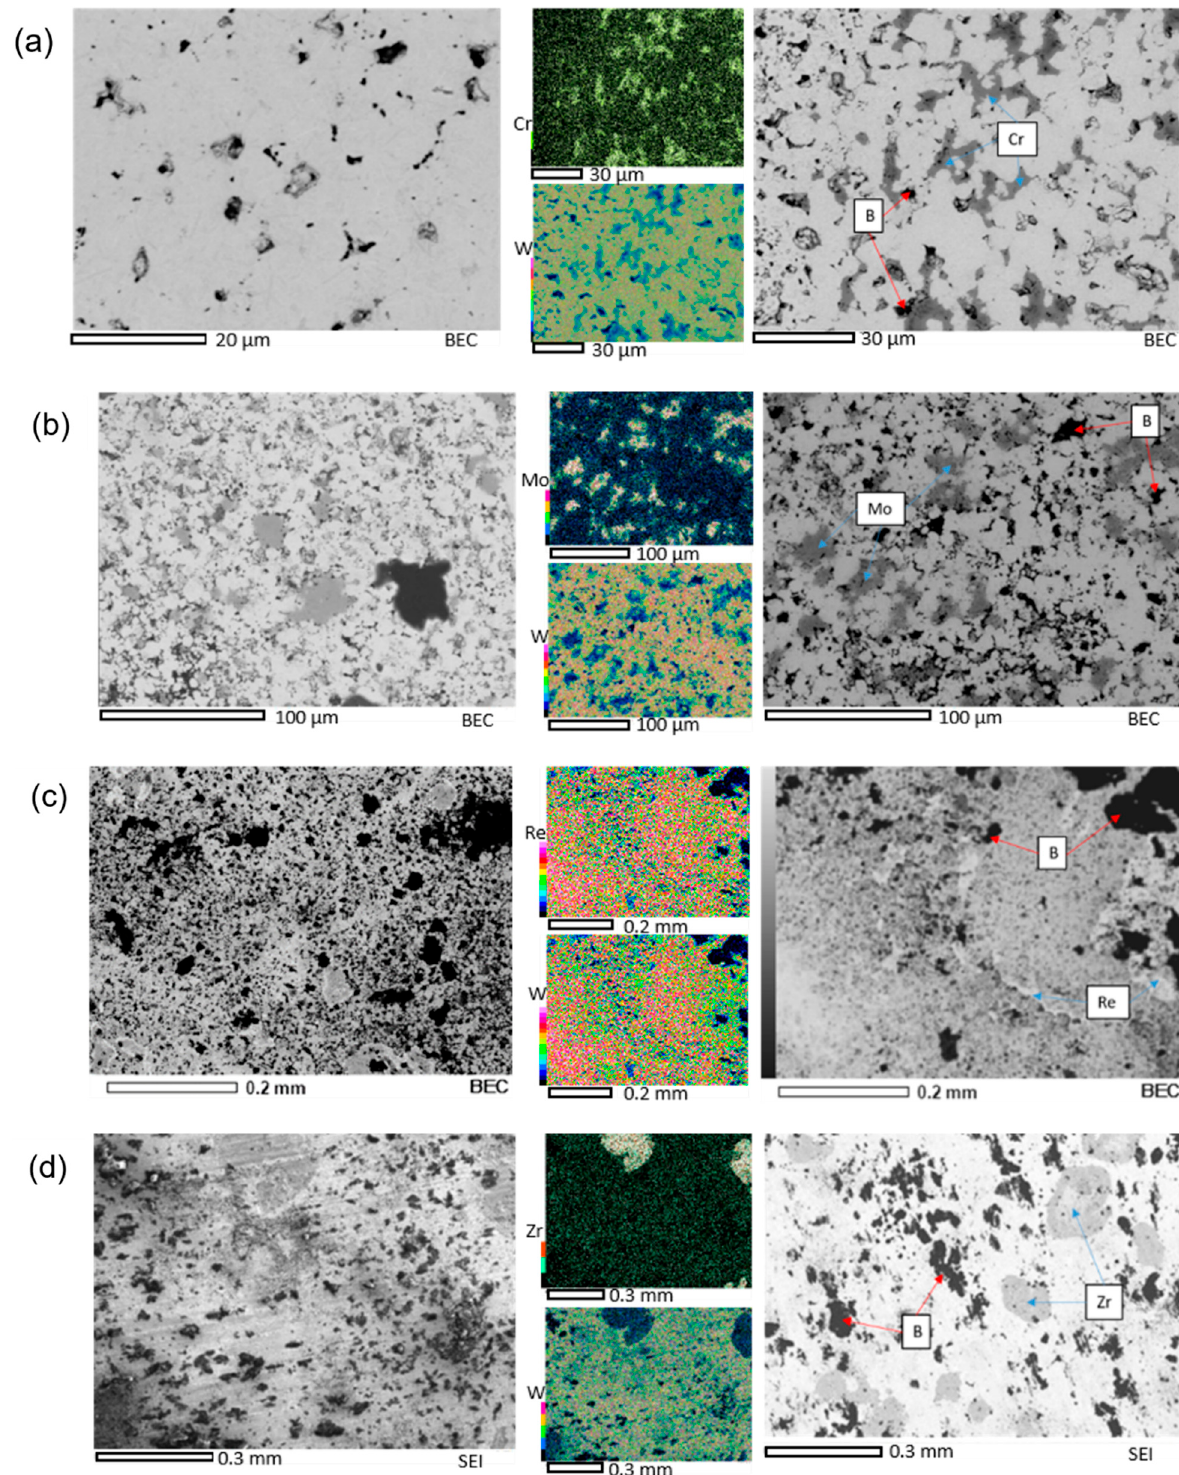
Figure 3. SEM micrographs and chemical analysis of (W,TM)B 2.5 sintered compact surface alloyed with 8 at.% and 24 at.% TM, where TM: ( a ) Cr, ( b ) Mo, ( c ) Re, ( d ) Zr. Left figures show results of 8 at.% of addition, right 24 at.% respectively and middle is an EDS analysis of W and TM content in 24 at.% samples. Only one element is presented in each picture. Black colour means 0% at. and pink 100% at. respectively.